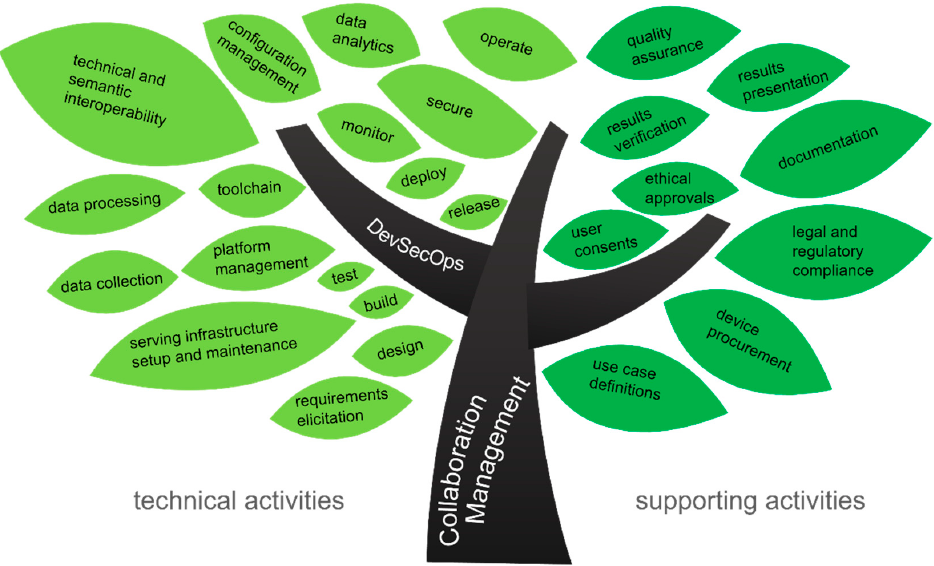
Figure 12. Activities in the AAL system integration and deployment process.